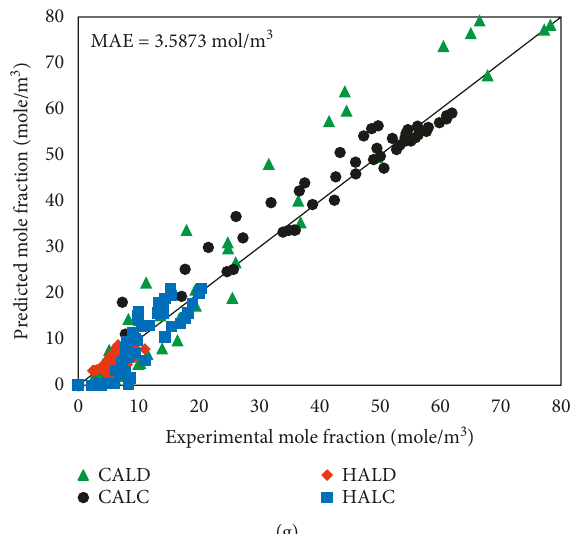
Figure 3: Parity diagram indicating the calculated molar fractions obtained by the bulk model versus the experimental molar fractions for all experiments and components. Modelling results have been obtained using the reaction mechanism (a) (RKP-non-competitive), (b) (RKP- competitive), (c) (RK1), (d) (RK2), (e) (RK3), (f) (RK4), and (g) (RK5). Table 3: Summary of the estimated errors. Kinetic